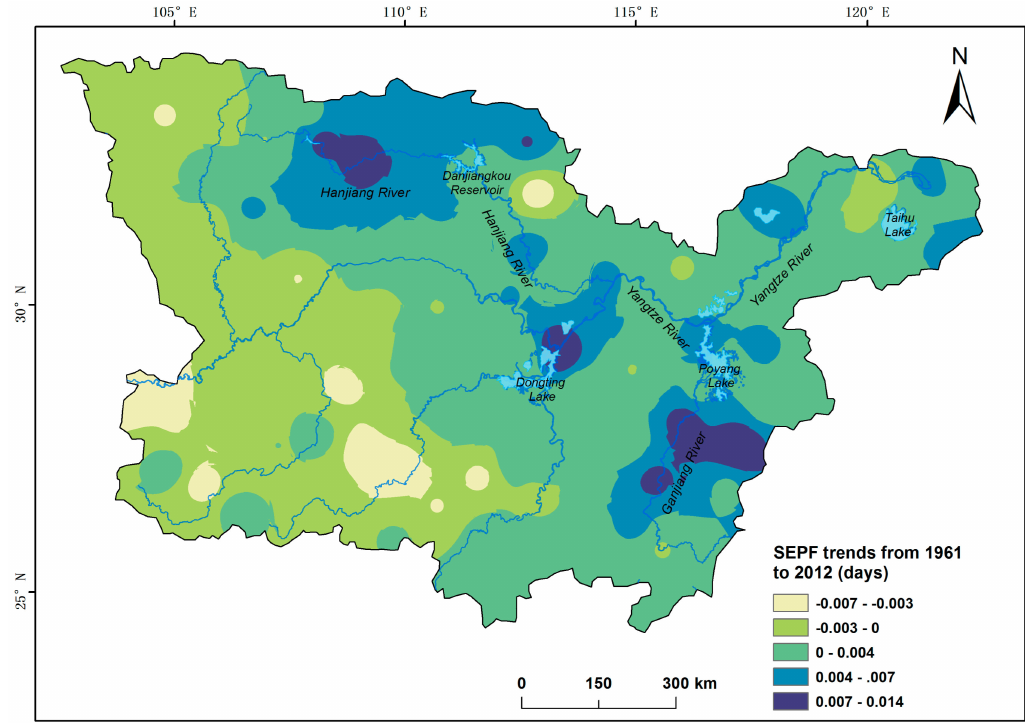
Figure 5. Trends in extreme precipitation frequency over the period of